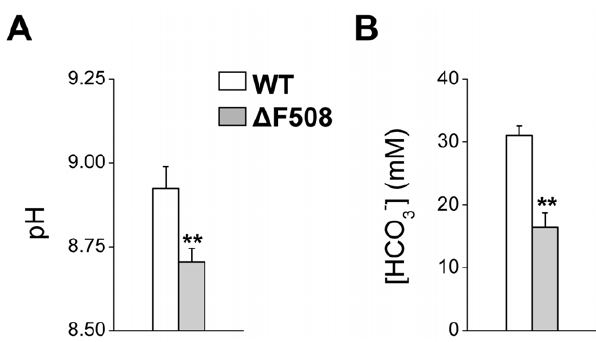
Figure 3. Saliva pH and bicarbonate concentration were dramatically reduced in D F508 mutant mice. Secretion was stimulated in non-infected mice by intraperitoneal injection of pilocarpine HCl (10 mg/kg). Panel A. pH value was measured immediately after saliva collection using a pH-sensitive electrode. Panel B. Bicarbonate was measured using an enzymatic-based colorimetric kit. Open and filled bars correspond to wildtype (WT, n=7) and mutant ( D F508, n=6) mice, respectively. Values are given as the mean 6 S.E.M. ** p , 0.01, t test.